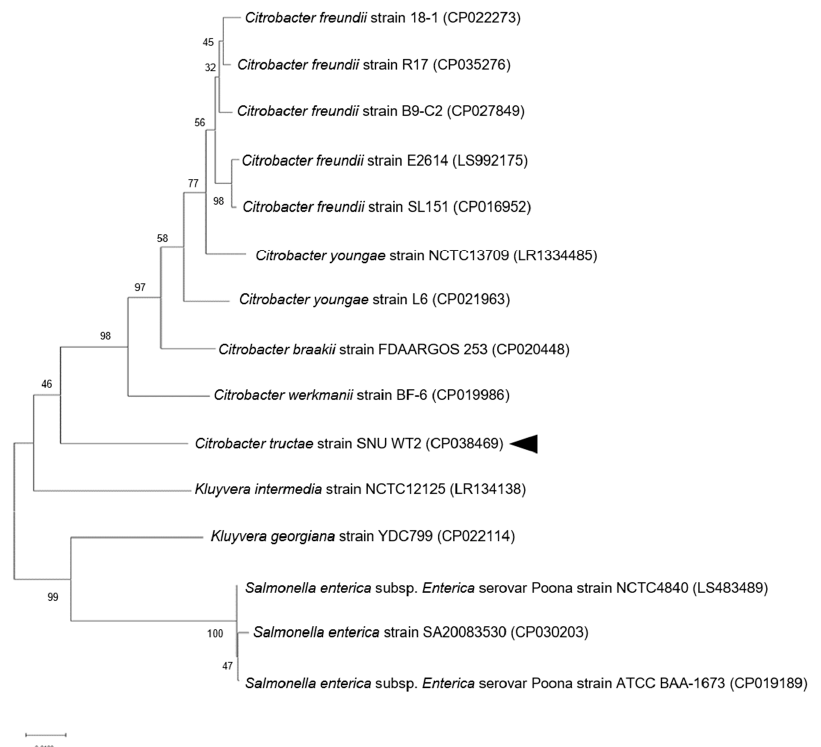
Figure 3. Phylogenetic tree based on four housekeeping genes ( gyrB (DNA gyrase), rplB (ribosomal protein L2), fusA (elongation factor G), and leuS (tRNA synthetase)) of the Citrobacter species: the maximum-likelihood method was used for the tree construction in MEGA 7.0 [29]. The bootstrap values obtained after 1000 replicates are provided at the nodes. Bar, 0.01 changes per nucleotide position. The arrow head indicates SNU WT2.